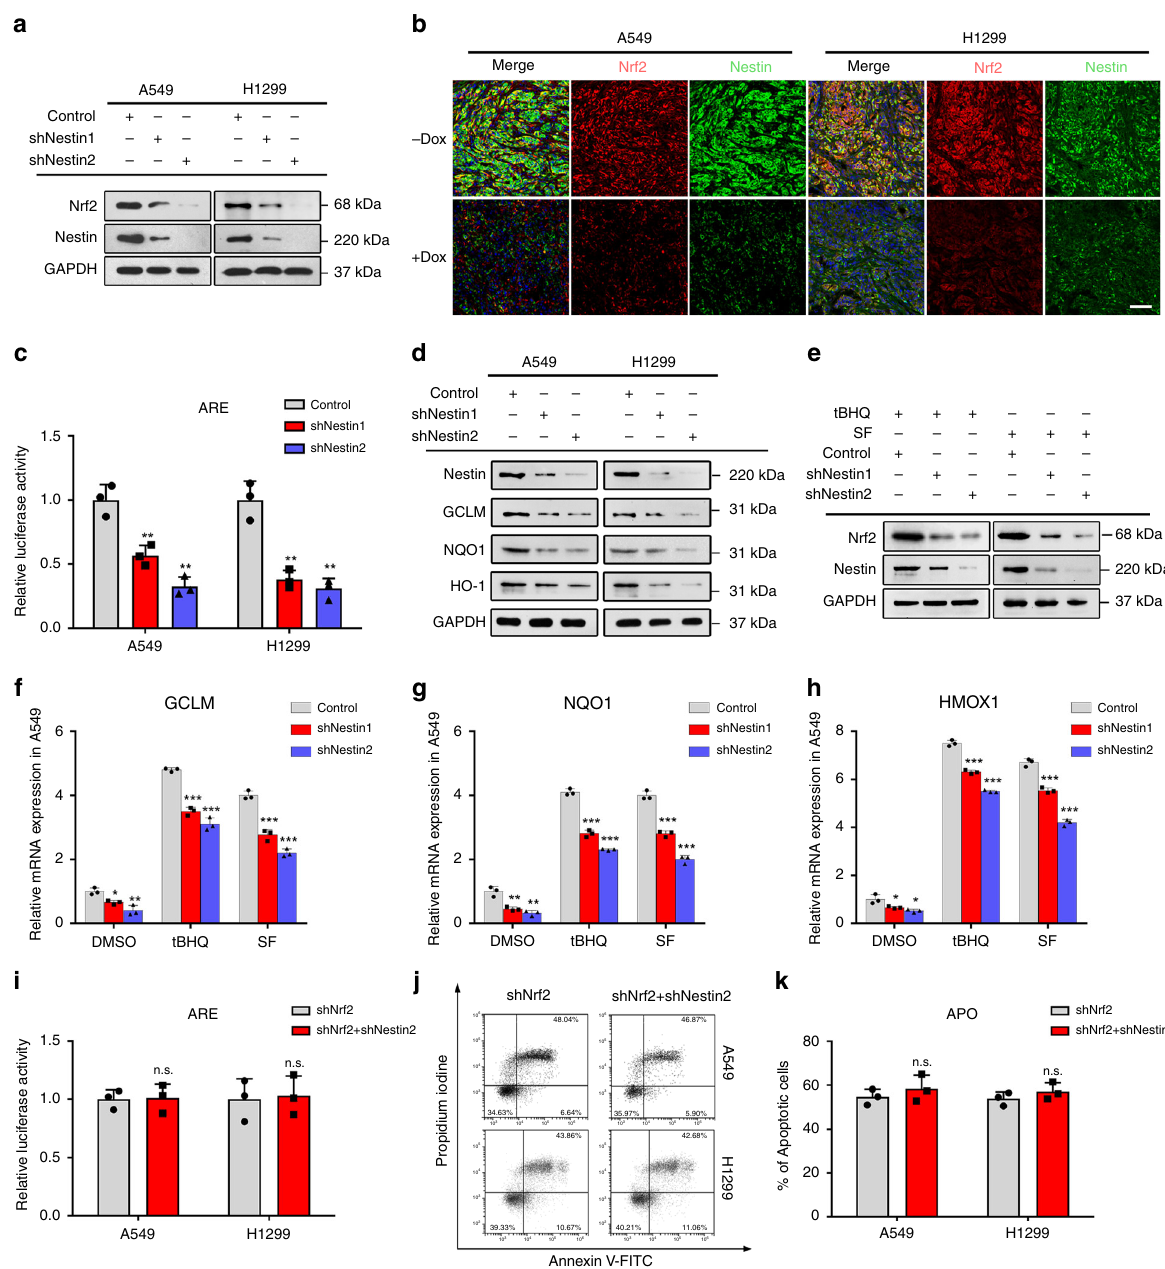
Fig. 2 The impact of Nestin on cellular antioxidant activity is mediated by the Nrf2 – ARE pathway. a Immunoblotting was performed to detect the expression levels of Nestin and Nrf2 in NSCLC cells with or without Nestin knockdown. b Immunostaining was performed on sections of the xenograft tumors using the Tet-On 3G doxycycline-inducible gene expression system. The xenograft tumor samples were labeled with anti-Nrf2 (red), anti-Nestin (green), and DAPI (blue). Scale bar: 50 μ m. c A luciferase assay was used to detect reporter gene activity from the AREs. NSCLC cells with or without Nestin knockdown were transiently transfected with an ARE luciferase reporter plasmid. At 24 h post-transfection, the cells were assayed for luciferase activity. The results are expressed as the fold-change of luciferase activity with respect to that of the vector control. d Western blot analysis representing the protein levels of NQO1, HO-1, and GCLM in NSCLC cells with or without Nestin knockdown. e The basal and induced protein levels of Nrf2 were lower in A549 cells with Nestin knockdown. NSCLC cells were treated with 100 μ M tBHQ or 20 μ M SF for 16 h to activate Nrf2. f – h The mRNA levels of Nrf2- downstream genes were analyzed by qPCR in Nestin-knockdown A549 cells. A549 cells were treated with DMSO (as a control), 100 μ M tBHQ, or 20 μ M SF for 16 h. i Nrf2-knockdown NSCLC cells transfected with vector or shNestin plasmids were transfected with the ARE luciferase reporter. At 24 h post- transfection, the cells were assayed for luciferase activity. j Nrf2-knockdown A549 cells transfected with vector or shNestin plasmids were treated with 200 μ M H 2 O 2 for 6 h, and fl ow cytometric detection of apoptosis was performed using Annexin V-FITC and PI. k Statistical analysis of the total apoptosis rates of the A549 cells described in j . The total apoptosis rates were calculated as the sum of the early and late apoptosis rates. Data are presented as the means ± SD of three independent experiments. ** P < 0.01, N.S. represents no signi fi cant, Student ’ s t- test. Source data are available as a Source Data fi